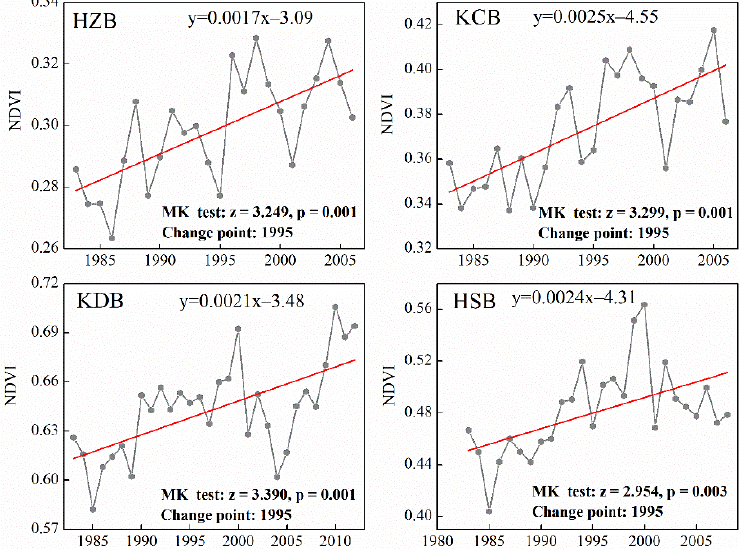
Figure 4. Annual variation of summer maximum NDVI derived from GIMMS for the four basins during 1983 − 2012. Change trends of NDVI have been determined by linear least-squares regression and the Mann – Kendall test.